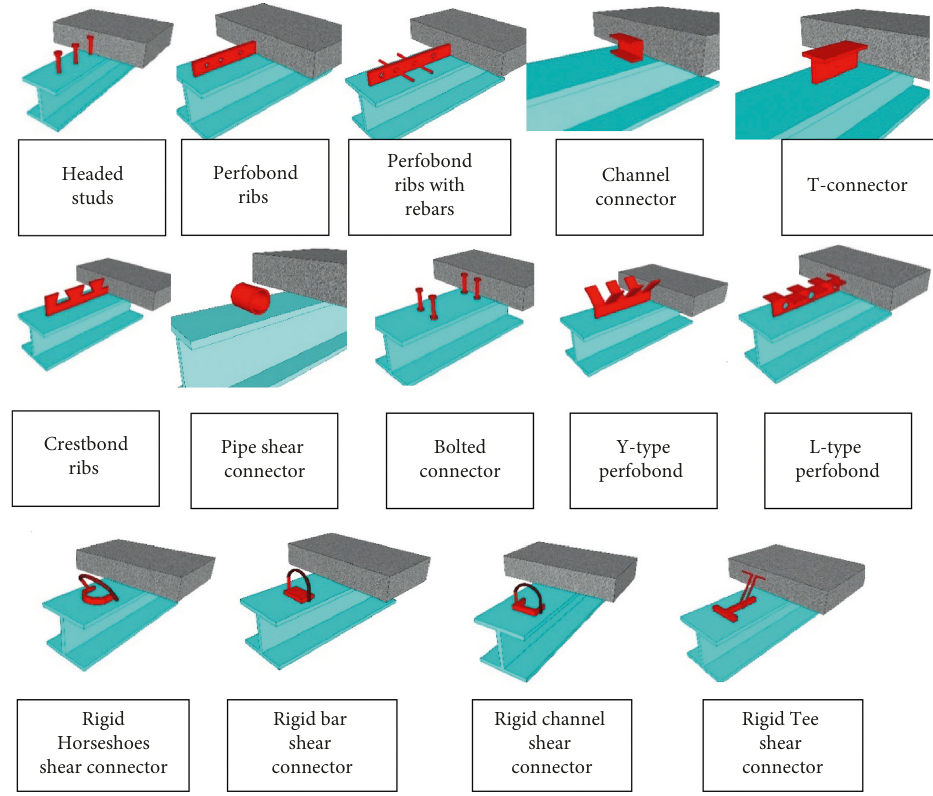
Figure 1: Types of shear connectors applied to the top of the steel